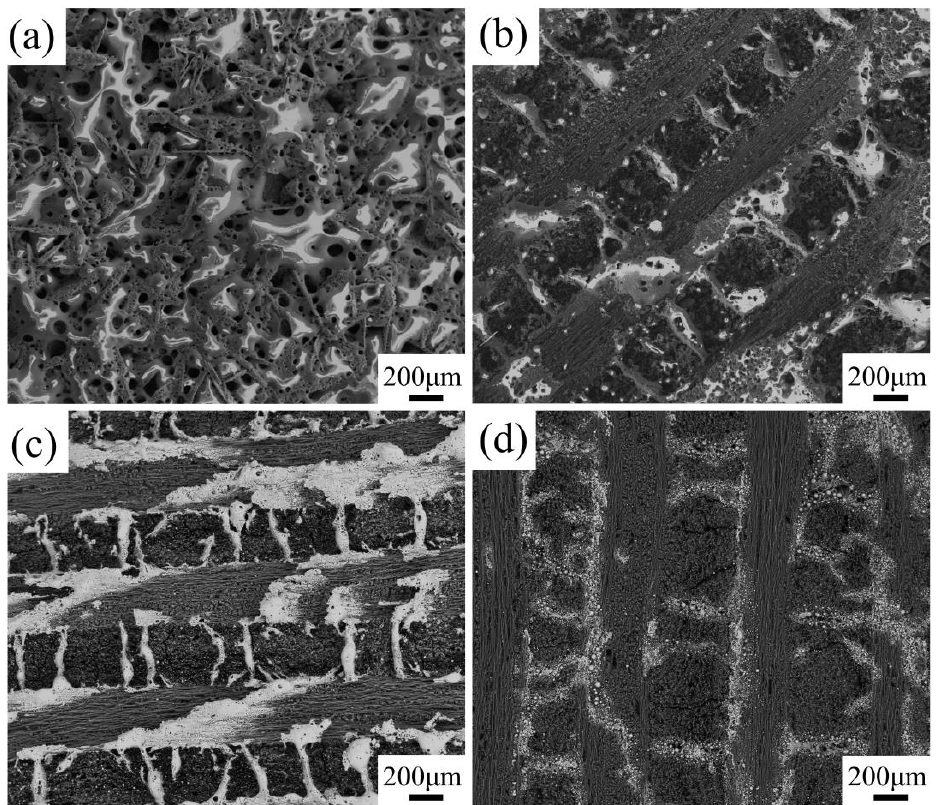
Figure 8. Surface micrographs of the central region of the AlSiB-C/C composites ablated for ( a ) 25 s, ( b ) 50 s, ( c ) 100 s and ( d ) 150 s. Table 2. Ablation properties of the composites.